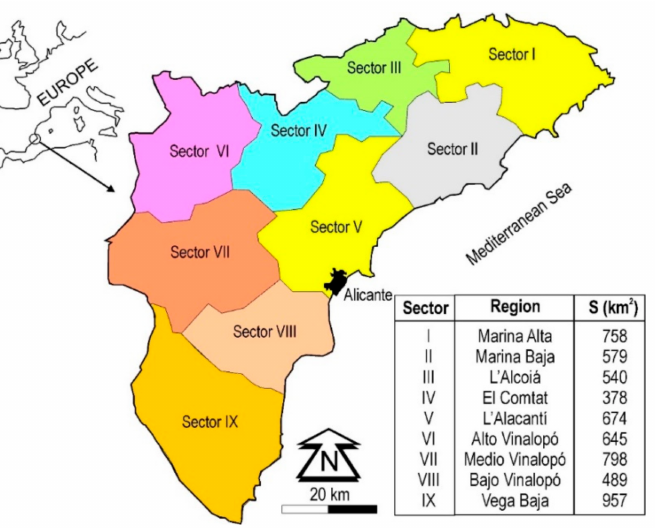
Figure 1. Map of Alicante, with the sectors used in this paper and their surfaces (S) in km 2 , coincident with traditional administrative